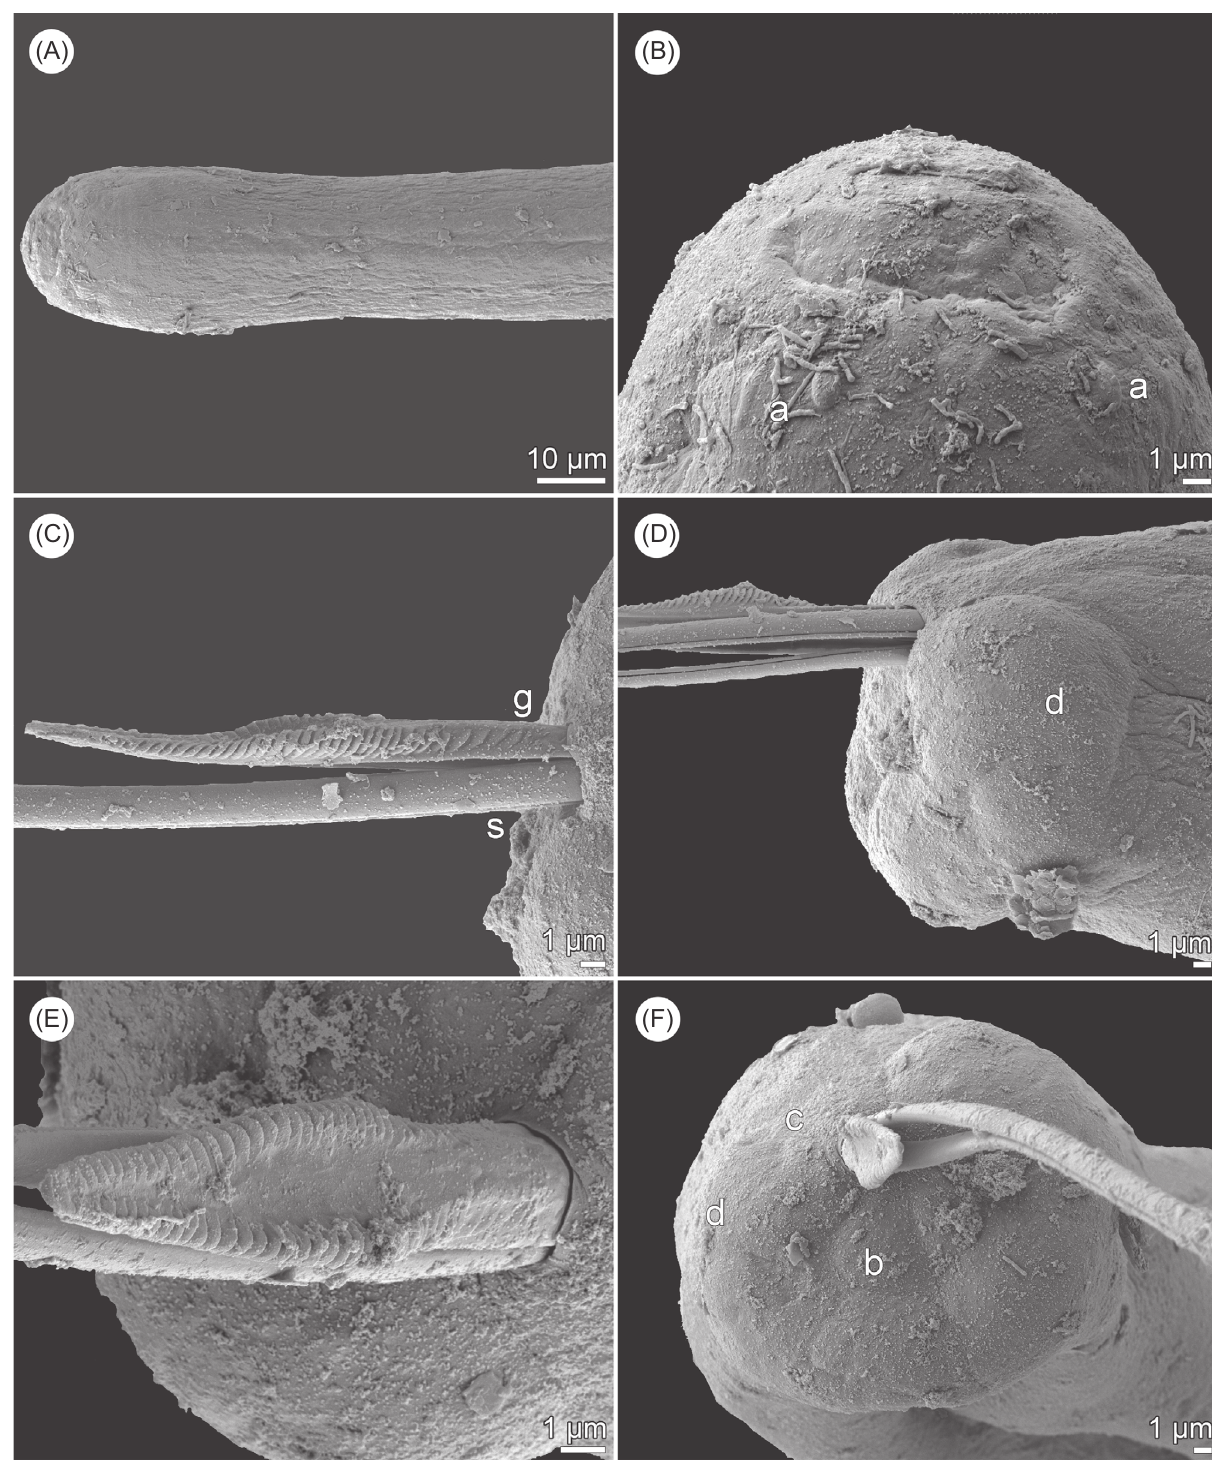
Figure 3. Philometra rara n. sp., scanning electron micrographs. (A) Anterior end of male; (B) cephalic end of male, dorsoventral view; (C) gubernaculum, lateral view; (D) caudal end of male, lateral view; (E) gubernaculum, dorsal view; (F) caudal end of male, apical view. Abbreviations: (a) submedian pair of outer cephalic papillae; (b) dorsal caudal papilla; (c) group of four adanal papillae; (d) caudal mound; (g) gubernaculum; (s)